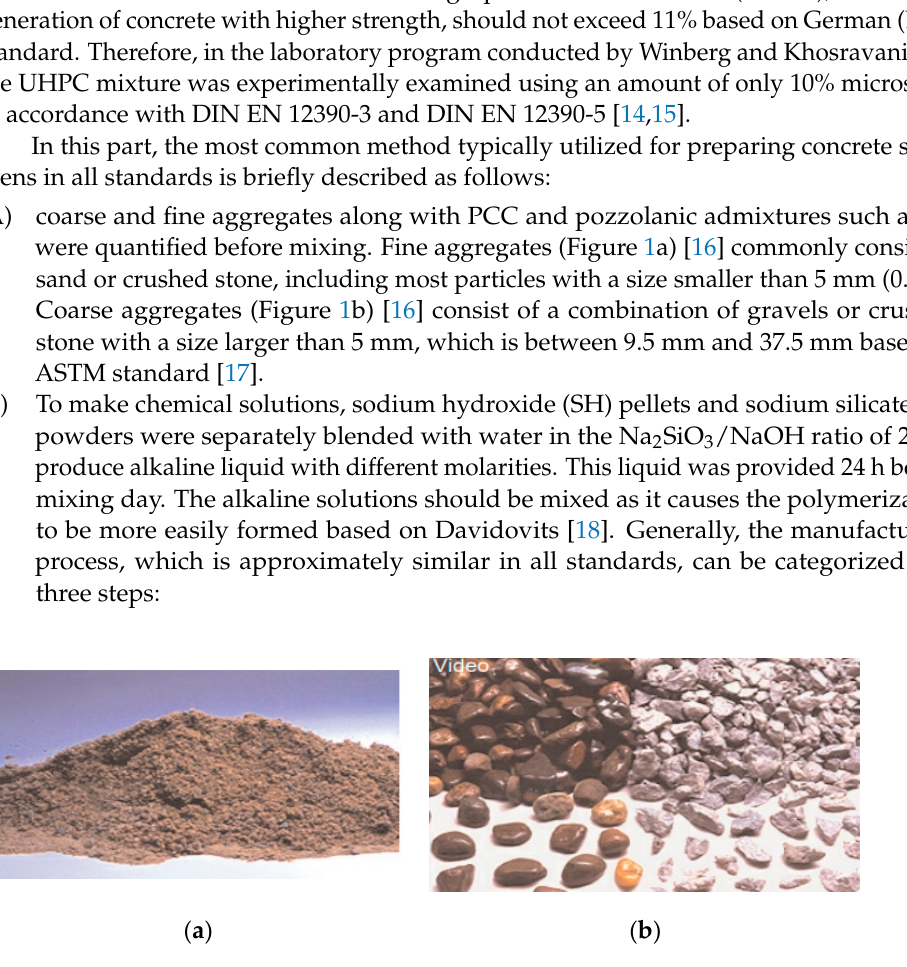
Figure 1. ( a ) Fine aggregate (0–5mm); ( b ) coarse aggregate (9.5–37.5mm)